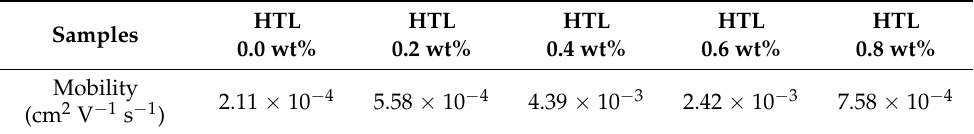
Table 3. The mobility of HTL consisting of Spiro-OMeTAD and different amounts of CsI (0.0, 0.2, 0.4, 0.6, and 0.8